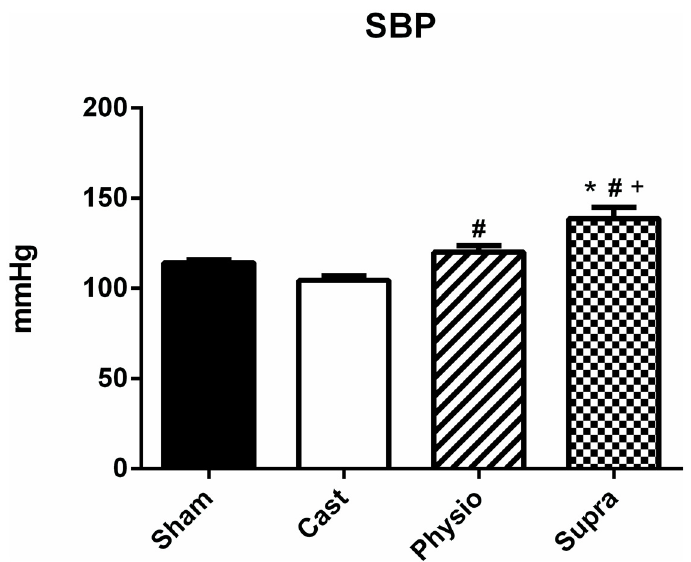
Fig 1. Systolic blood pressure of normotensive rats. SHAM (n = 15), CAST (n = 15), PHYSIO (n = 21), and SUPRA (n = 15) groups. The values are expressed as the mean ± SEM. * p < 0.05 compared with the SHAM group, #p < 0.05 compared with the CAST group, and +p < 0.05 compared with the PHYSIO group.